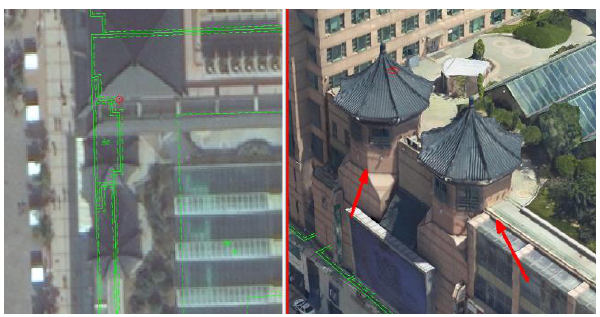
Figure 5 . Missing permanent room.